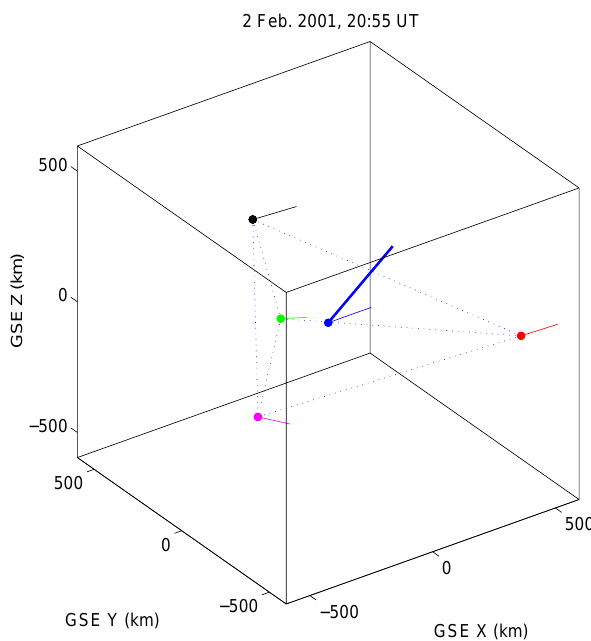
Fig. 7. A summary of the different estimates of the direction nor- mal to the SLAMS surface: model normal (heavy blue line), timing derived normal (fine blue line), minimum variance directions esti- mated at the individual spacecraft (Cluster 1, 2, 3 and 4 represented by black, red, green and magenta,